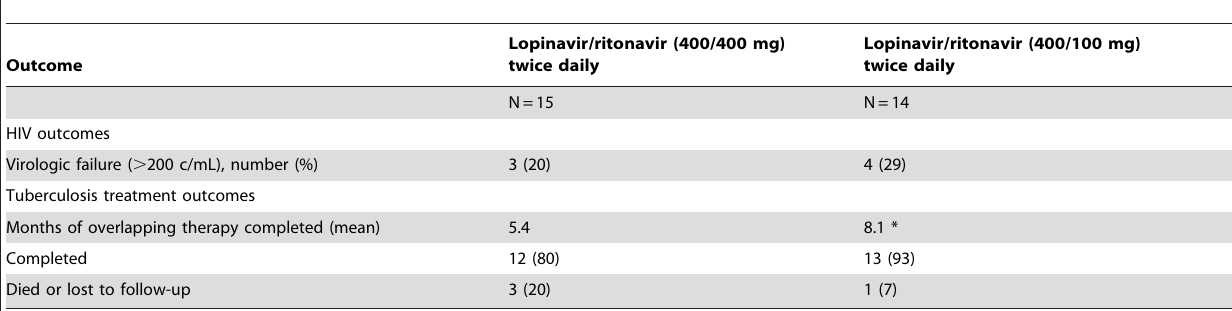
Table 2. Clinical outcomes associated with coadministration of lopinavir/ritonavir-based ART and rifampicin-containing TB